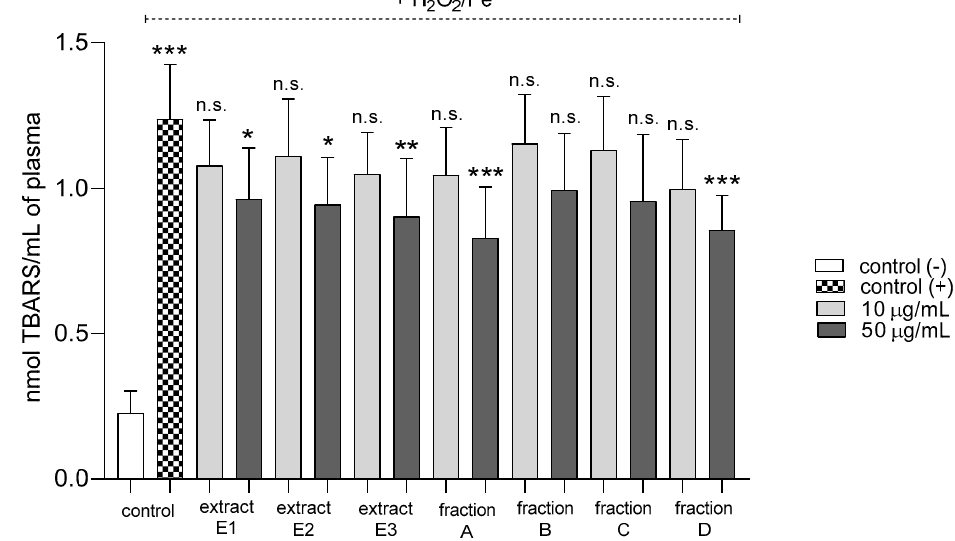
Figure 2. Effects of extracts (E1–E3) and flavonoid fractions (A–D) of dandelion fruits (concentrations 10 and 50 µg/mL) on lipid peroxidation in plasma treated with H 2 O 2 /Fe. The data are presented as means ± SD ( n = 10). Control negative refers to plasma not treated with H 2 O 2 /Fe, and control positive to plasma treated with H 2 O 2 /Fe. Kruskal-Wallis test: n.s. p > 0.05, * p < 0.05, ** p < 0.01, *** p < 0.001, compared with positive control.